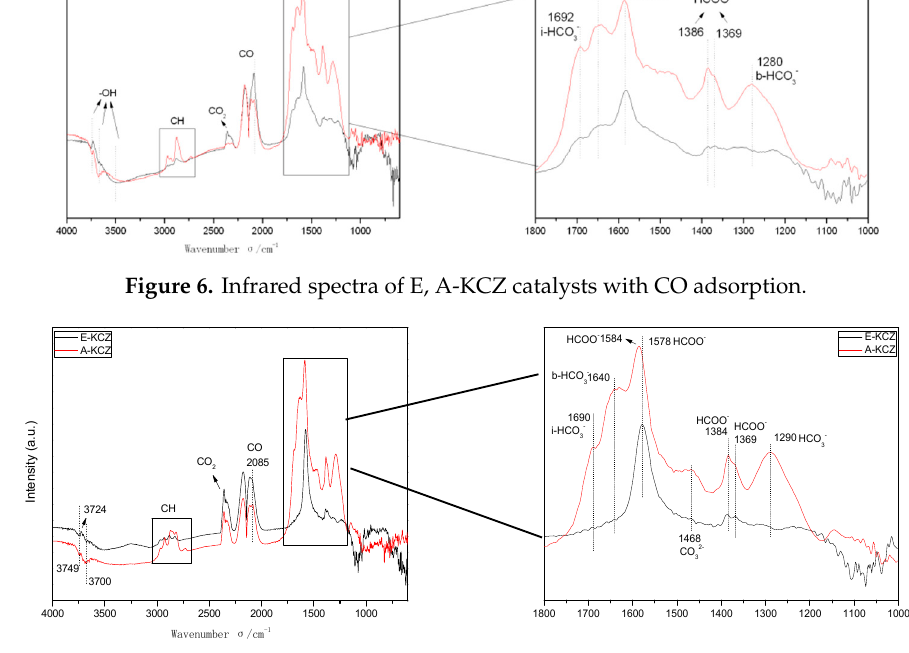
Figure 7. Infrared spectra of E, A-KCZ catalysts with H 2 / CO adsorption.